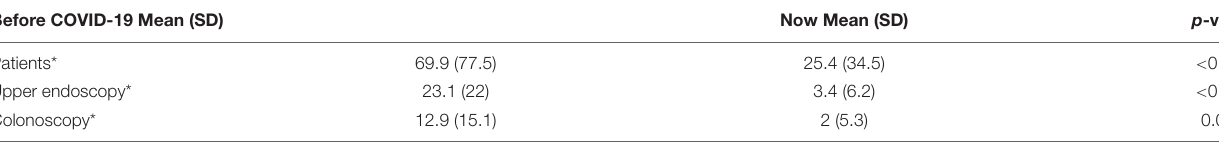
TABLE 4 | Characteristics of activities before and in the time of COVID-19.